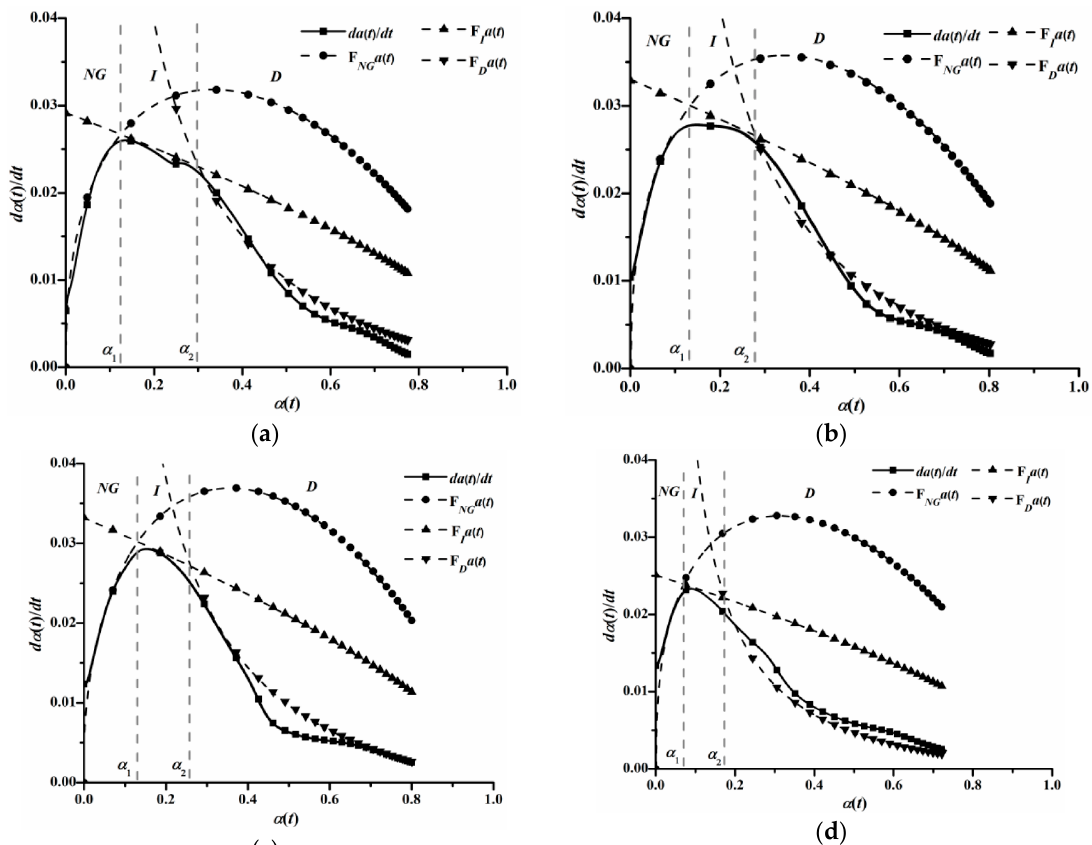
Figure 6. Hydration kinetic process curves of groups with various C 12 A 7 replacements. ( a ) M0; ( b ) M2; ( c ) M5; ( d ) M7.